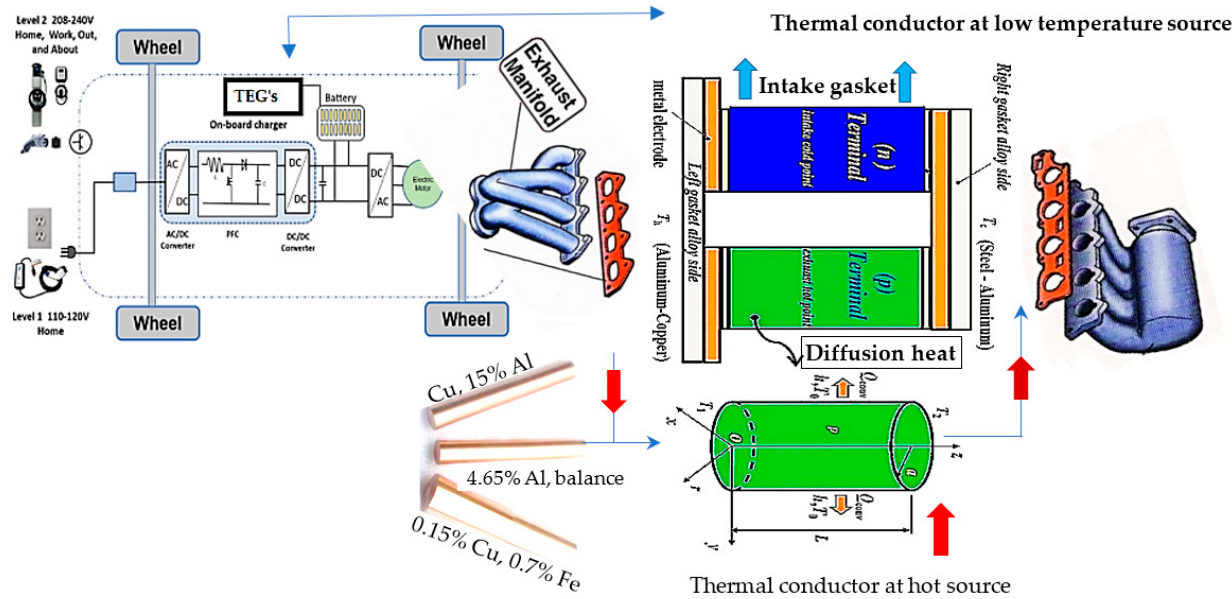
Figure 2. The components of the engine under study and TEG according to Dandan Pang, et al., (2022) [37].